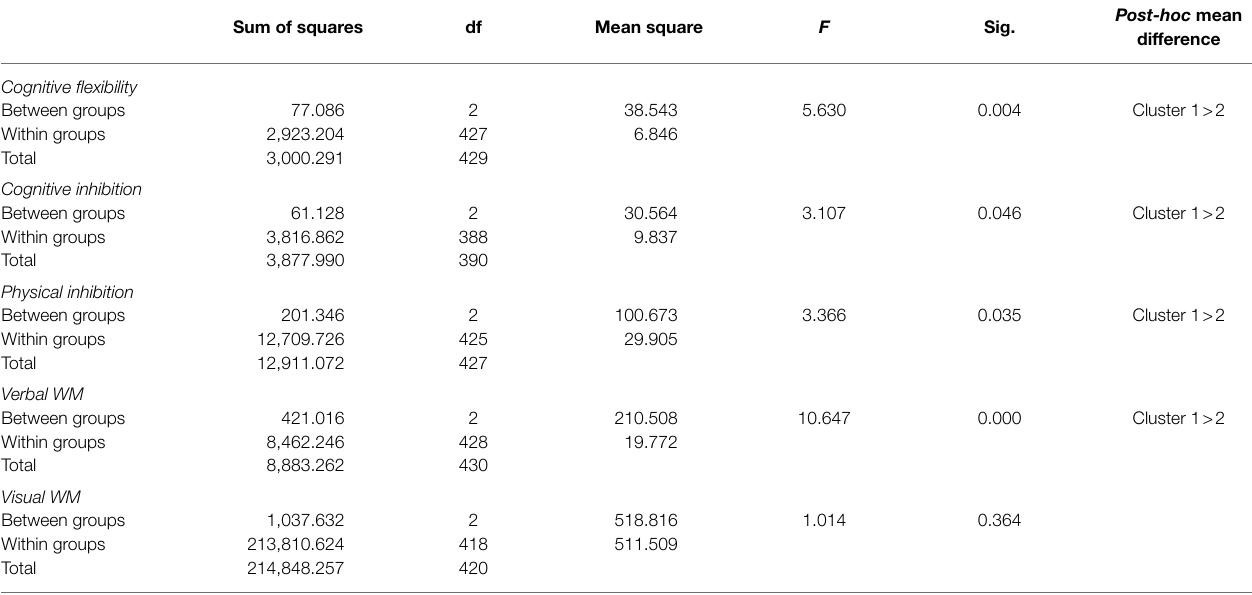
TABLE 6 | Differences in scores of different aspects of executive functions in different clusters. Sum of squares df Mean square F Sig.